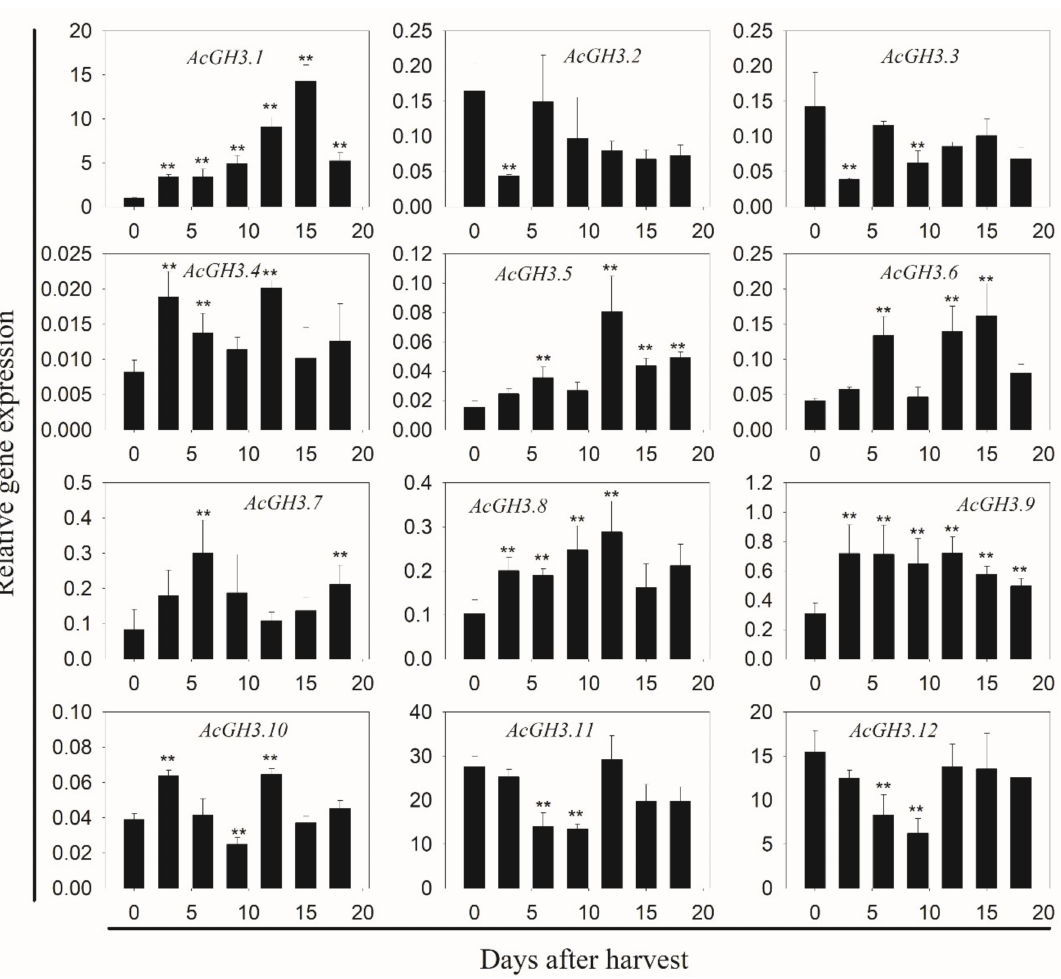
Figure 2. q-PCR analysis of 12 AcGH3 genes in a total of seven postharvest stages. X-axis represents the di ff erent stages of postharvest. Y-axis represents the relative mRNA levels of genes. Expression of Actin was used as an internal control and to normalize the expression of AcGH3 genes. All values in the figure are relative to the AcGH3.1 value on day zero after harvest. Error bars show the standard error between three replicates performed. Asterisks indicate a significant di ff erence relative to day zero after harvest according to a student’s t-test (** p <